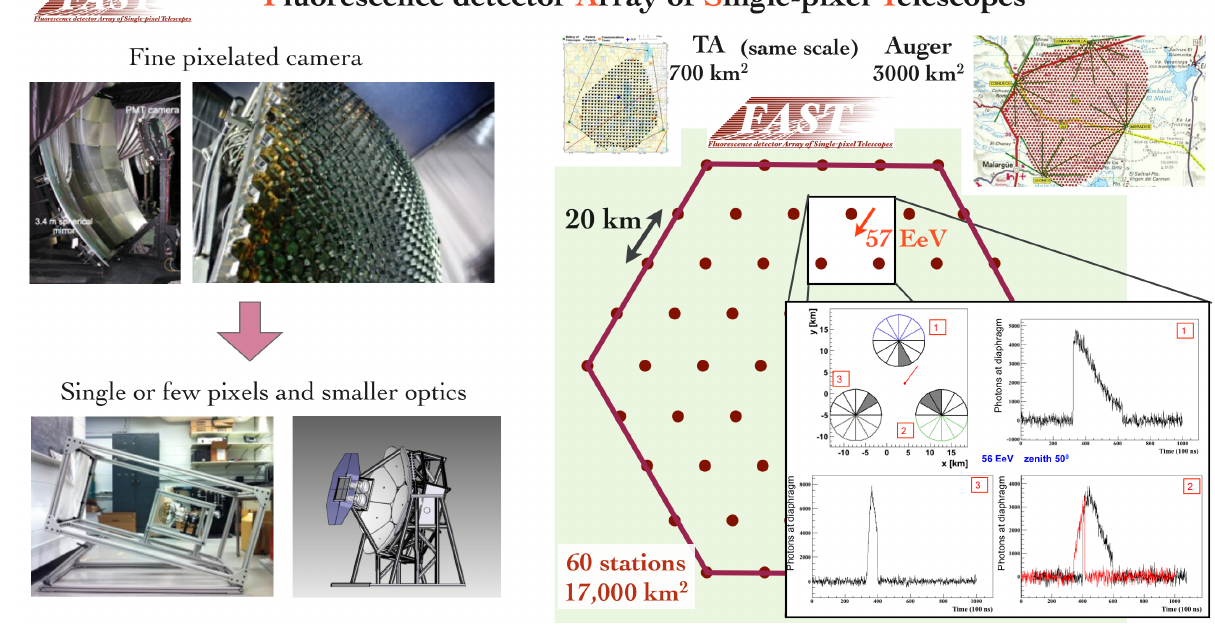
Figure 4. The UHECR observatories and their exposures at the highest energies as a function of time; including AGASA [29], High Figure 5. Schematic view of the Fluorescence detector Array of Single-pixel Telescopes: one of the possible solutions for a future giant Resolution Fly’s Eye [30], Auger [16], TA [17, 18]. The pioneering detection of UHECRs from space, K-EUSO [31], is also indicated. ground array [33]. As a reference, the ground coverages of TA and Auger make up only 10% of the ground coverage of a full-scale array of FAST detectors. The expected signal emitted from a UHECR with an energy of 57EeV is shown in a